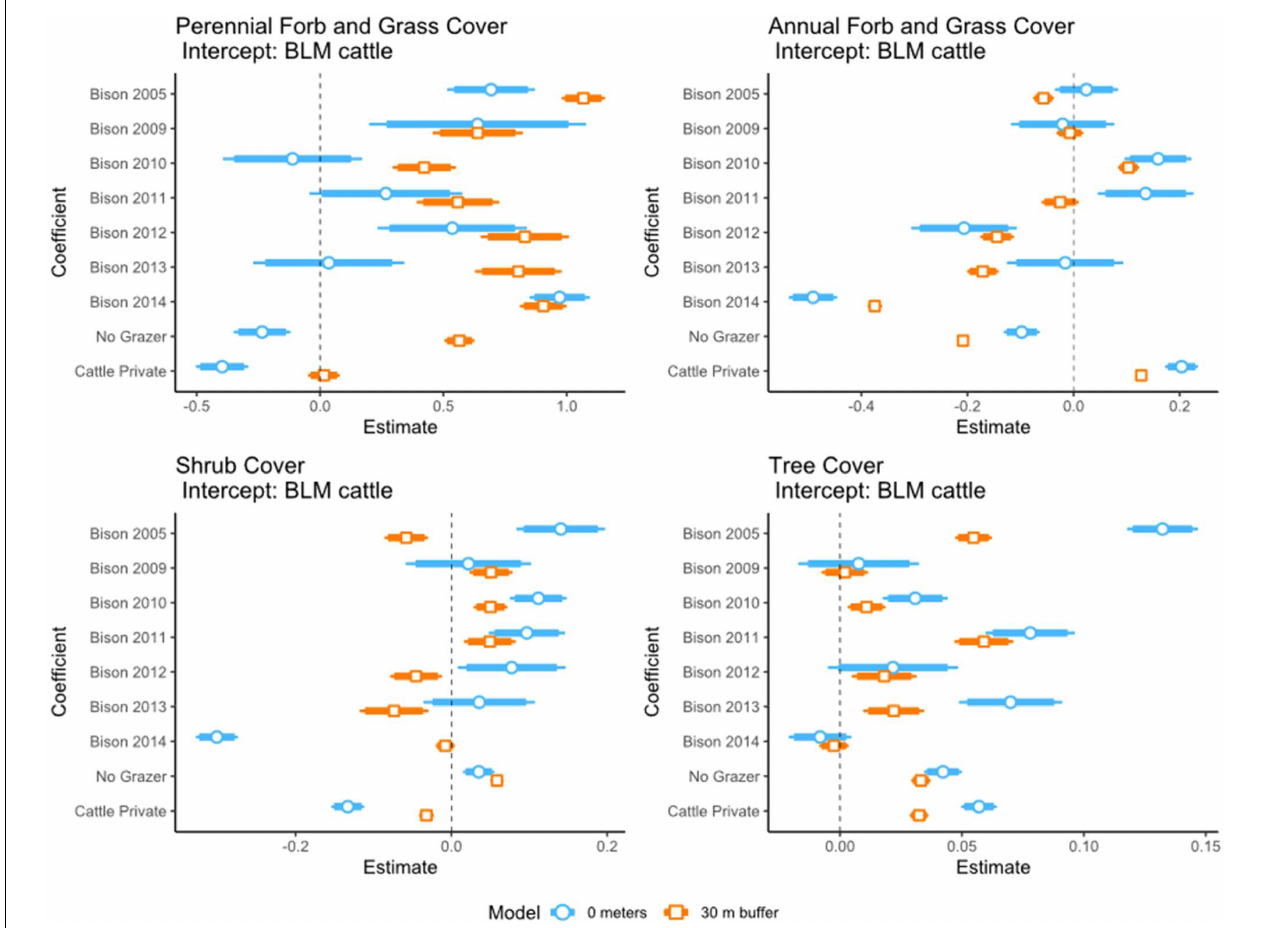
FIGURE 3 | Long-term vegetation trend estimates (slope) in relation to grazing treatment. Intercept: BLM cattle grazed streams. Vegetation: perennial forbs and grasses, annual forbs and grasses, shrub cover, and tree cover. Treatment: BLM cattle, Bison (2005, 2009, 2010, 2011, 2012, 2013, 2014), no grazers, private lands cattle. Models were run for two distance categories: (1) 0 m from stream; (2) < 30 m from stream